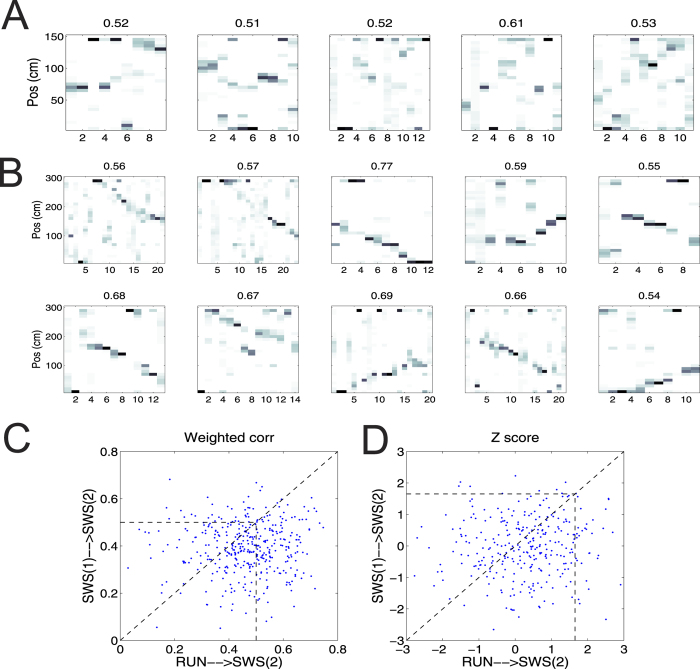
SWS-associated ensemble spike data analysis.(A,B) Examples of detected significant pre-SWS (A) and post-SWS (B) reactivation events. The number at the top of each panel indicates |R|. X-axis represents time bin (bin size Δ = 20 ms). (C,D) Testing predictability of RUN and SWS(1) data for SWS(2): scatterplot comparison of weighted correlation (C) and Z-score (D) between RUN → SWS(2) and SWS(1) → SWS(2). Lower left corner marked by dashed line indicates the non-significance zone.